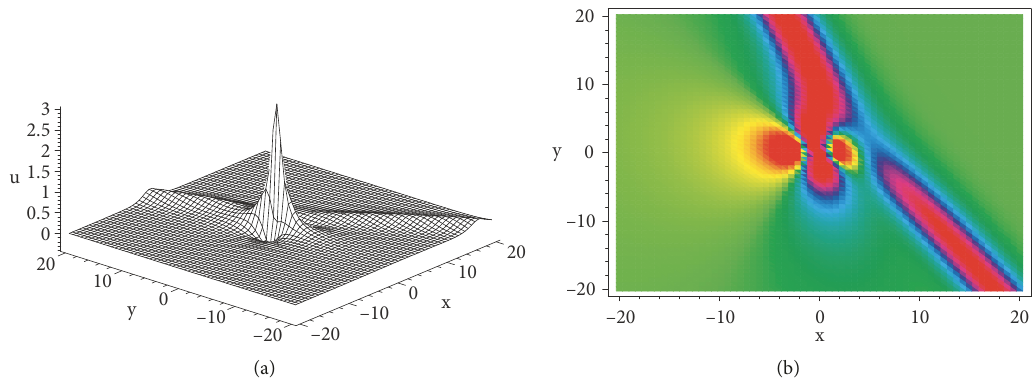
Figure 1: The interaction solution between a lump and one soliton of (9). (a) 3-dimensional plot with the time 𝑡 = 0 ; (b) the corresponding density plot.